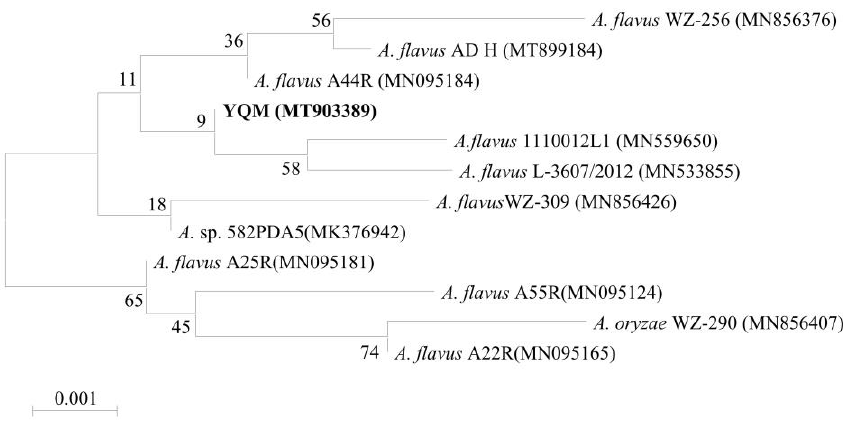
Figure 2. Phylogenetic tree of strain YQM and closely related reference strains of Aspergillus flavus based on 18S rRNA gene.